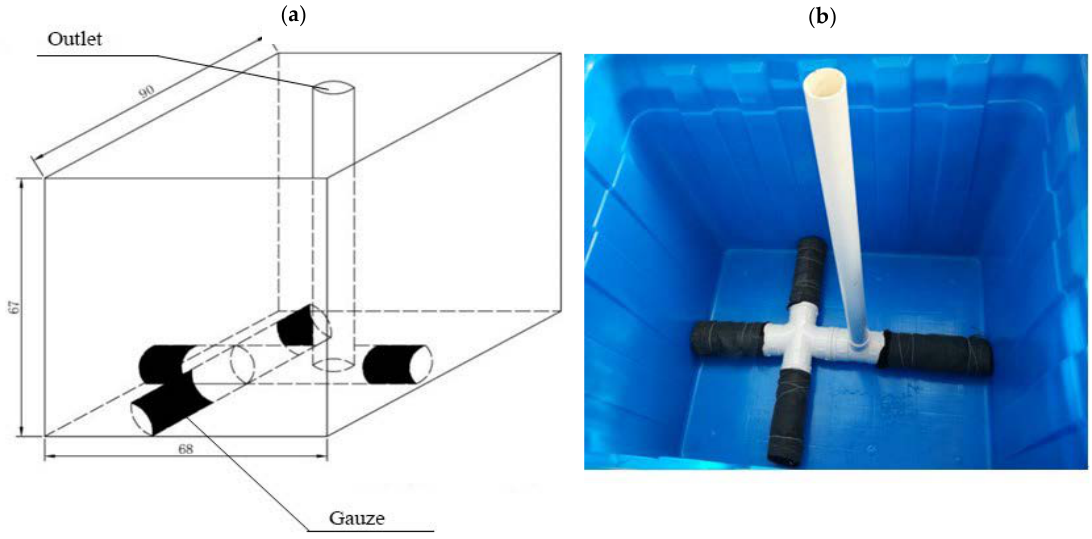
Figure 2. ( a ) Schematic diagram of pot planting experiment; and ( b ) physical diagram of pot planting experimental device.